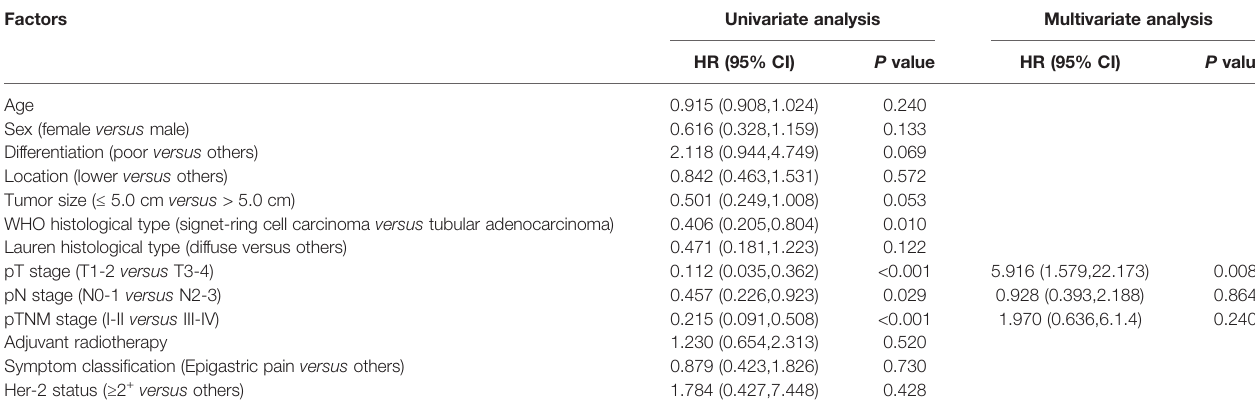
TABLE 3 | Univariate and multivariate analyses for overall survival associated with resectability of EOGC